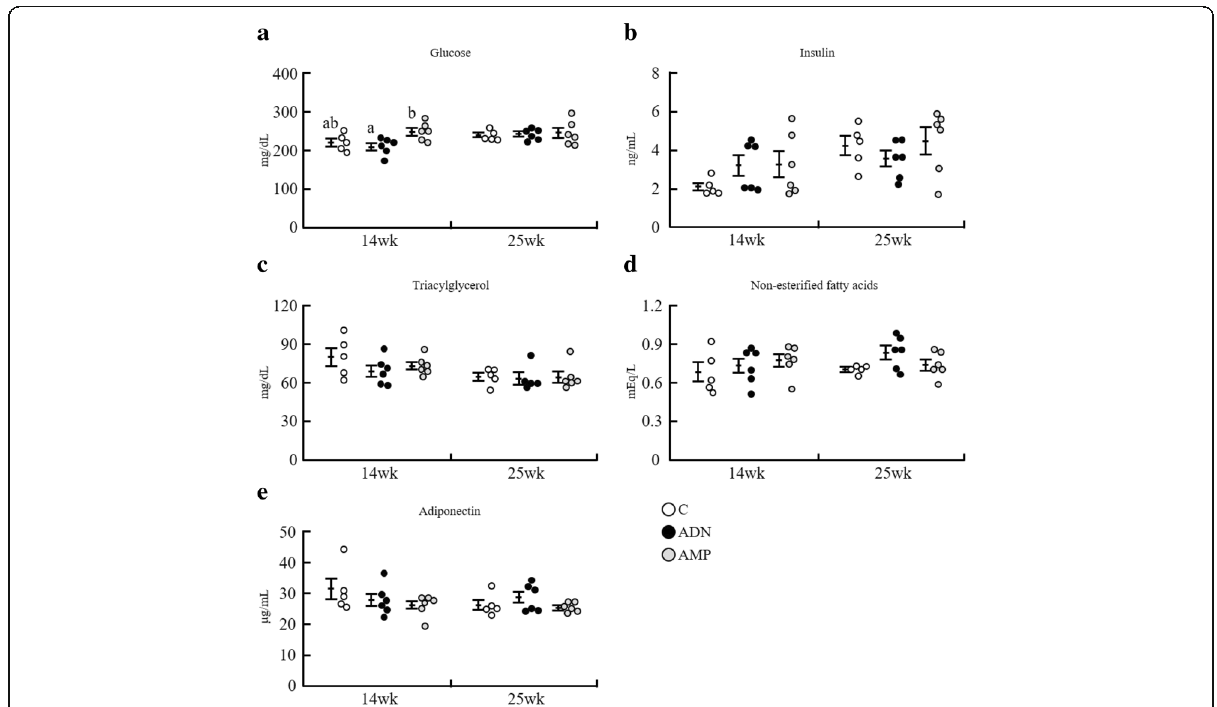
Fig. 2 Serum biochemical parameters of mice with high-fat diet-induced obesity administered ADN or AMP after fasting 6 h. a Glucose; ( b ) insulin; ( c ) triacylglycerol; ( d ) non-essential fatty acids; ( e ) adiponectin. Values are means ± SEM, n = 5 or 6. * p < 0.05 versus the control group. Different letters in the same panel represent a significant difference ( p <0.05). C, control group; ADN, adenosine group; AMP, adenosine-5 ′ -monophosphate